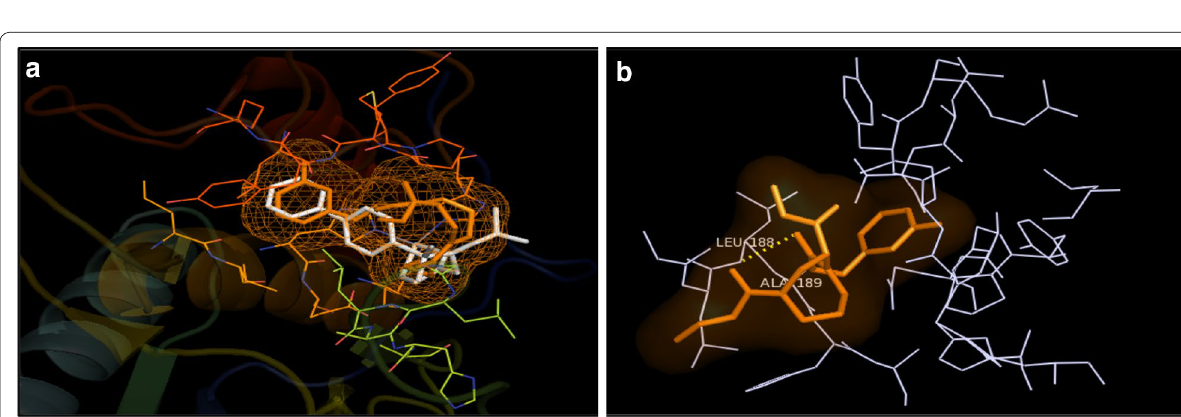
Fig. 9 a Overlay of the docked pose of compound 8 (orange) with that of PDB Ligand 4H3X (white); b docked pose: H-bond interaction of com- pound 8 in the binding site of MMP-9 protein